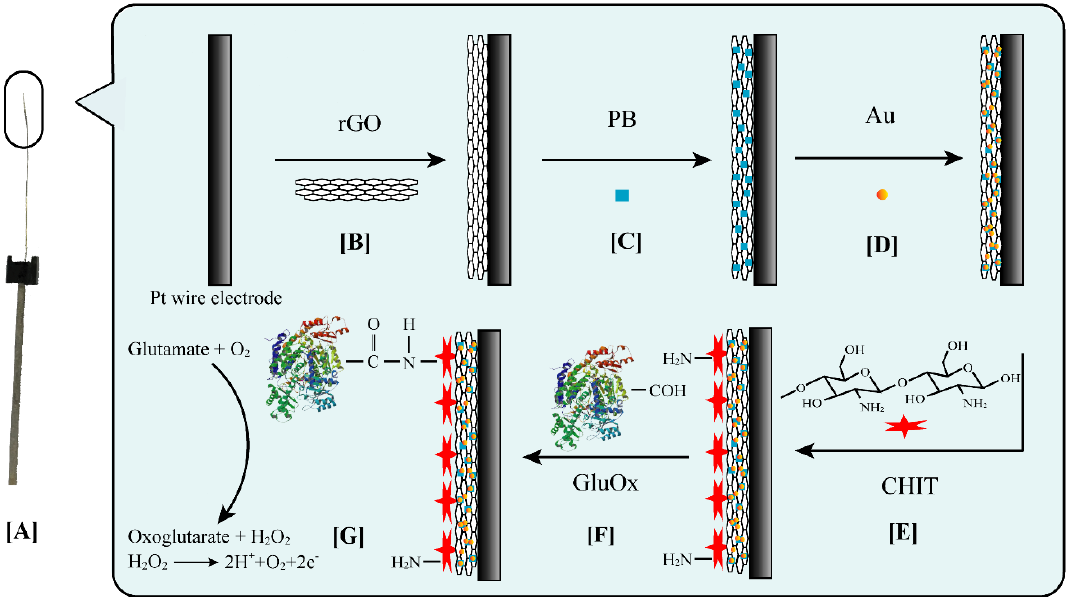
Figure 1. Schematic diagrams of the stepwise coating processes of the activated platinum wire. ( A ) The platinum wire fixed on a conductive connecting rod; ( B ) graphene oxide (GO) was reduced on the platinum surface; Prussian blue ( C ), gold ( D ), and chitosan ( E ) were electrodeposited; ( F ) immobilization of glutamate oxidase; ( G ) electrochemical redox of glutamate and hydrogen peroxide.